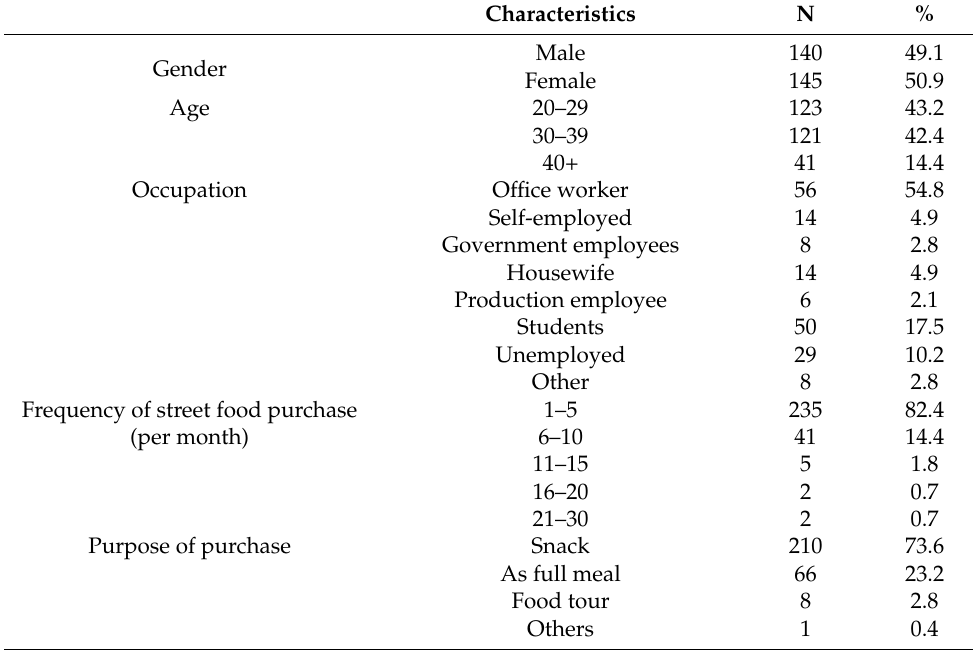
Table 1. Demographic characteristics of respondents ( n =